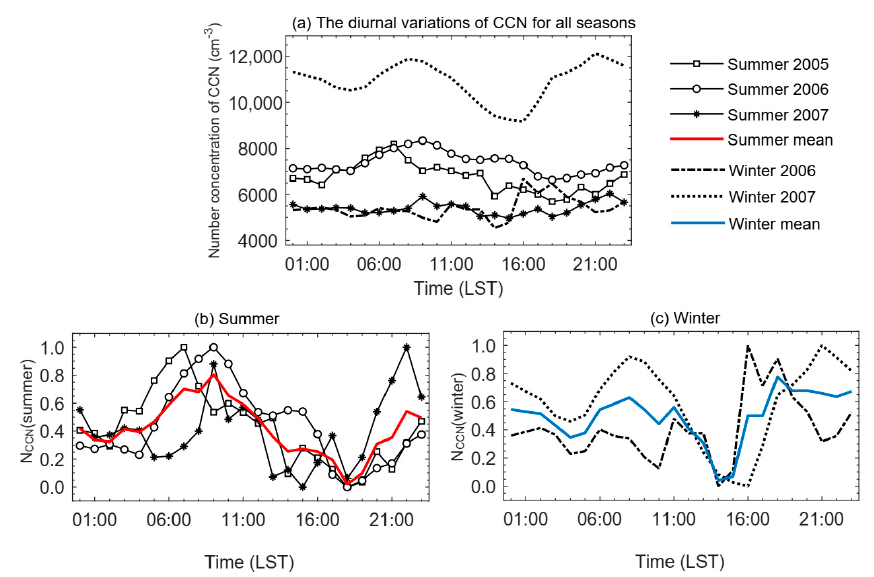
Figure 2. The diurnal variation of N CCN in different periods under SS = 0.3%. ( a ) The absolute variations of N CCN in winter and summer; ( b , c ) are normalized results for summer (N CCN ( summer ) ) and winter (N CCN ( winter ) ), respectively. Data can be found in the supplementary materials.